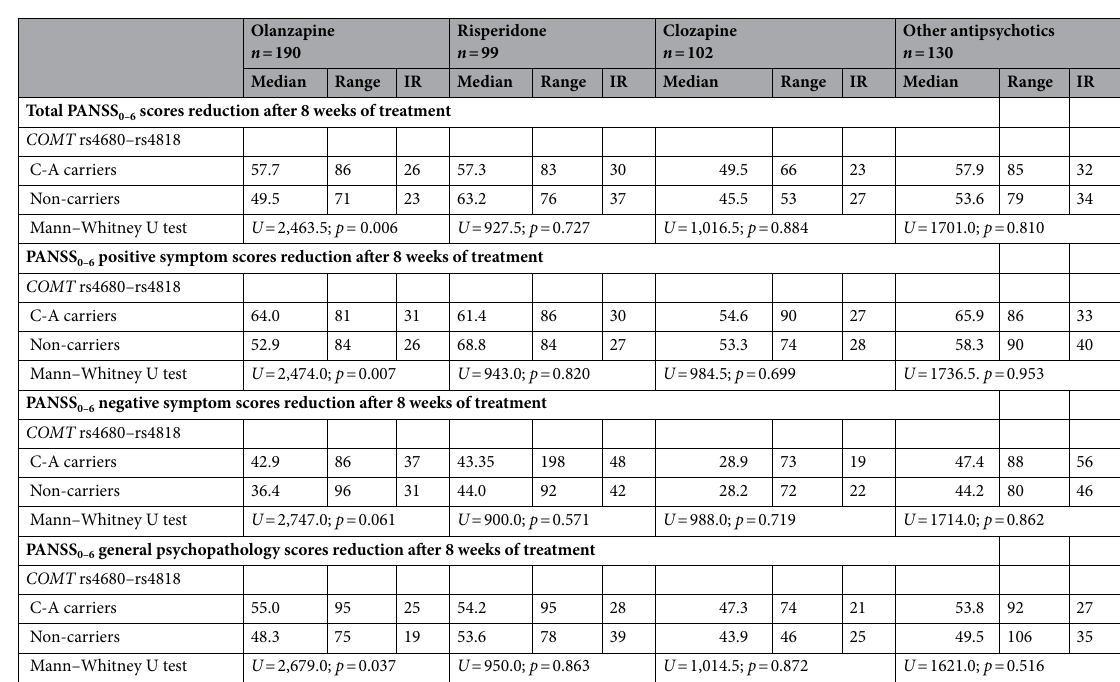
Table 8. Percentage reduction from the initial PANSS 0–6 total and subscale scores after 8 weeks of treatment with olanzapine, risperidone, clozapine or other antipsychotics in schizophrenic patients subdivided according to the COMT rs4680–rs4818 haplotypes into C-A haplotype carriers and carriers of the other haplotypes (non- carriers). Values are given as median, range and interquartile range (IR). n number of subjects, PANSS positive and negative syndrome